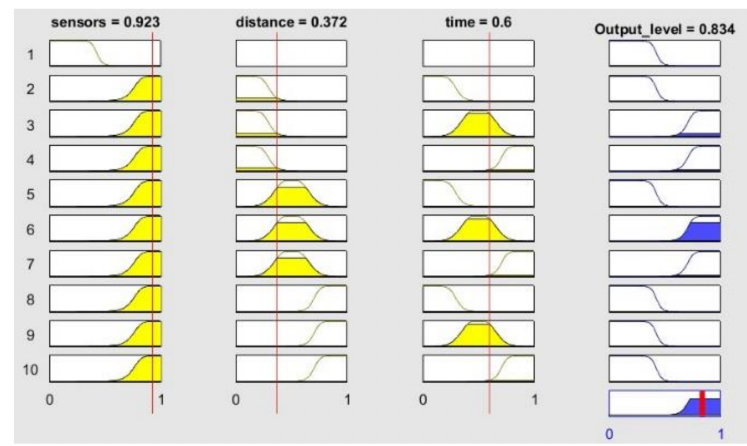
Figure 12. Fuzzy rules for the simulated case.